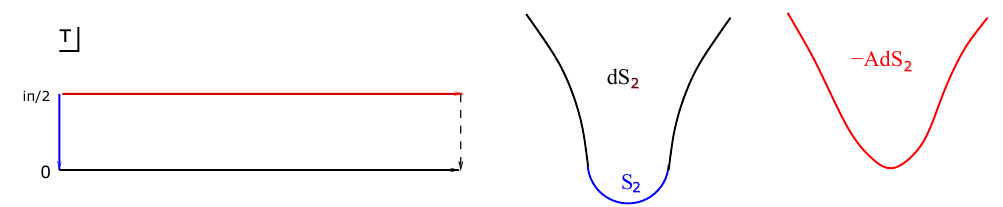
Figure 11 . The two di(cid:11)erent contours one can take in the complex metric space parametrised by (cid:28) . The blue line describes a Euclidean S 2 , the black Lorentzian dS 2 and the red negative Euclidean AdS 2 . The dashed line is a complex geometry connecting the last two types of geometries. (Adapted from [31]).